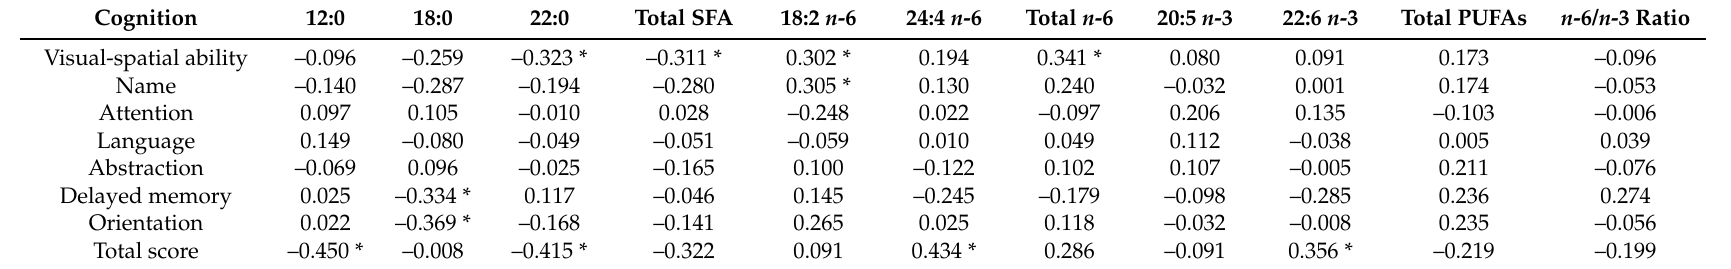
Table 4. Correlation coefficient ( r ) between erythrocyte fatty acids and cognitive function in MCI subjects ( n =